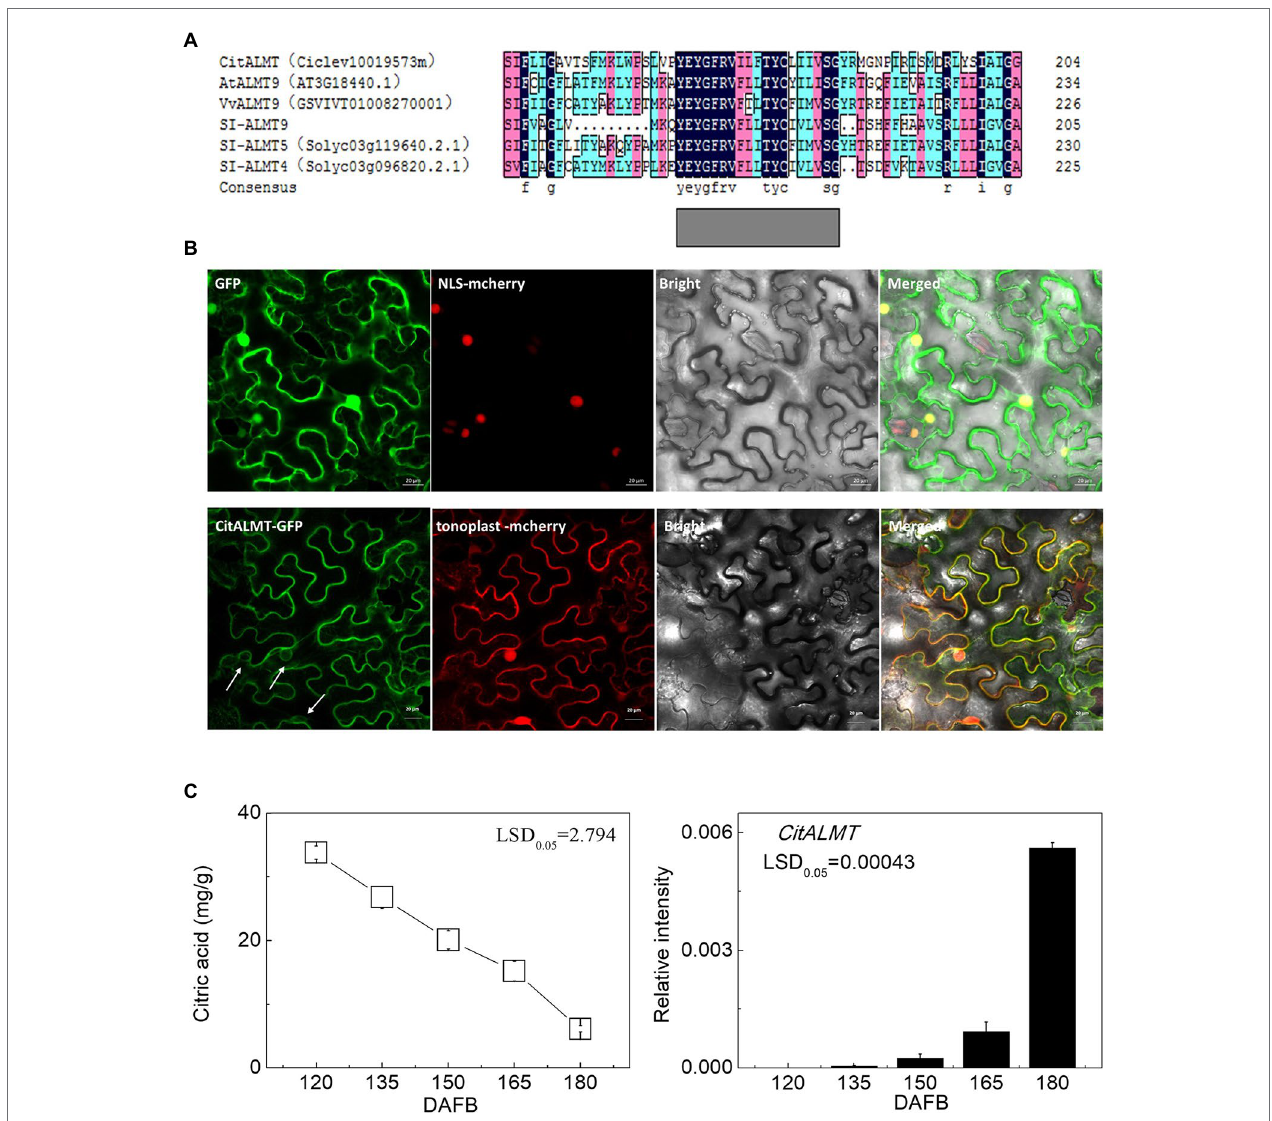
FIGURE 1 | Identification of CitALMT. (A) The amino acid sequences analysis of CitALMT compared with some ALMTs reported previously. (B) Subcellular localization of CitALMT in tobacco leaves stably transformed with a red nuclear localization marker and agroinfiltrated with CitALMT-GFP and tonoplast-RFP marker. White arrows highlight co-localization of CitALMT with tonoplast marker. The empty vector control is on the top without tonoplast-RFP marker. The fluorescence was measured at 488 nm with a LSM780 microscope and photographed. Bars = 20 μ m. (C) The citrate concentration and expression of the CitALMT genes in flesh of “Ponkan” fruits during the late stage of fruit development. DAFB, days after full